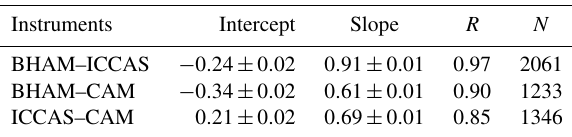
Table 5. RMA regression relationships of HONO measured by BHAM–ICCAS–CAM during the co-located measurements at the start of the summer campaign (22–30 May 2017). All three inlet locations were the same as the formal winter intercomparison. Vari- ability shown is the 95% confidence interval of the slope and inter-